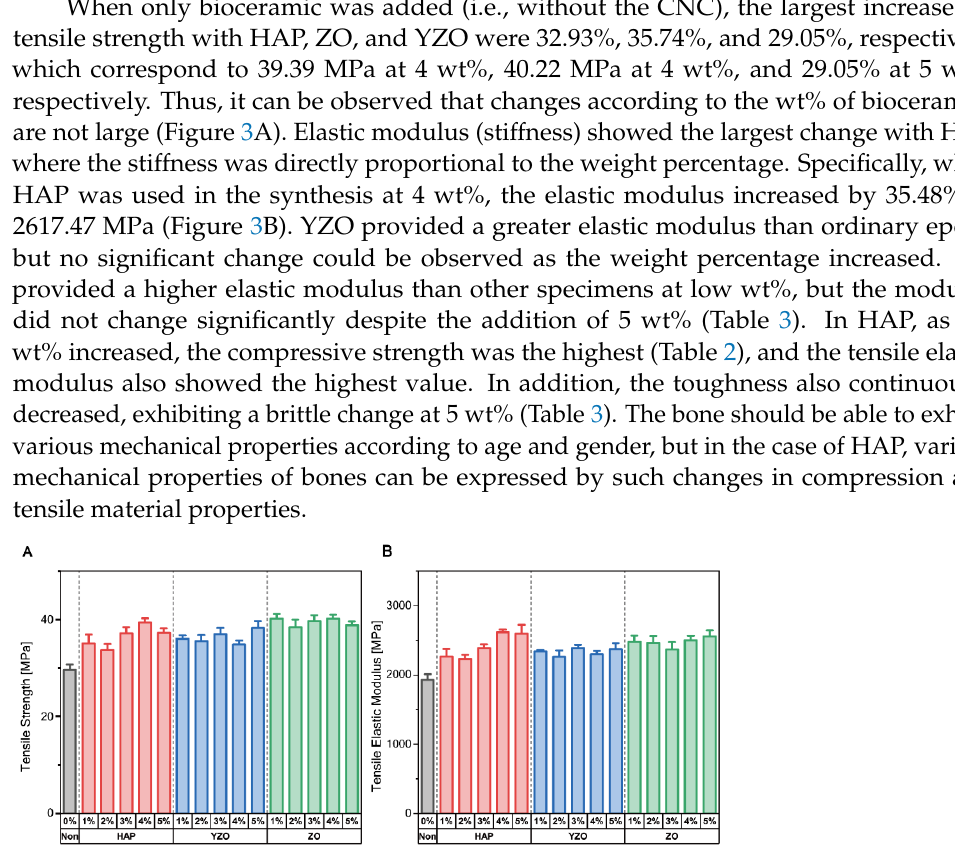
Figure 3. Results of the tensile test of different types of bioceramic–epoxy composite materials. ( A ) Tensile strength. ( B ) Elastic modulus. ( C ) Toughness. ( D )